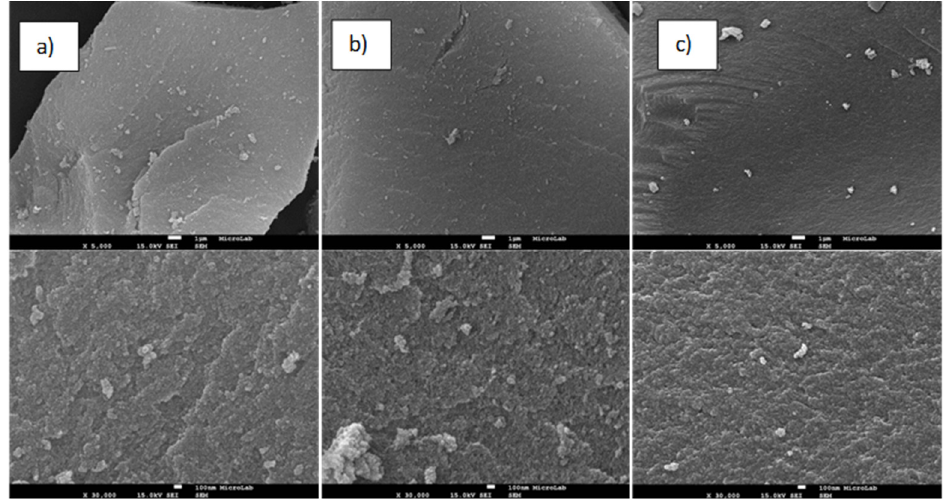
Figure 10. SEM images of silica aerogels (SIL2): ( a ) blank sample, ( b ) Zn(II)-AHBD impregnation and ( c ) Zn(II)-AHBD + [Aliquat][Cl] impregnation. The first line corresponds to a 5.000 magnification and the second line 30.000 magnification.